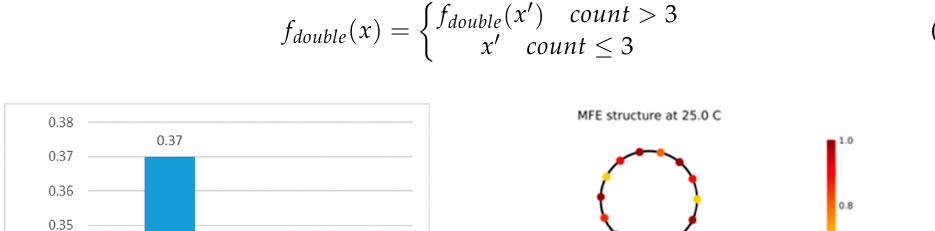
Figure 2. Analysis results of sequence TCTGTACTGCTGACTCGAGT. ( a ) Sequence species and concentration after the sequence enters the solution; sequences A and A-A obtained by the comple- mentary pairing reaction after the analyzed sequence enters the solution; ( b ) the secondary structure diagram of sequence A-A.